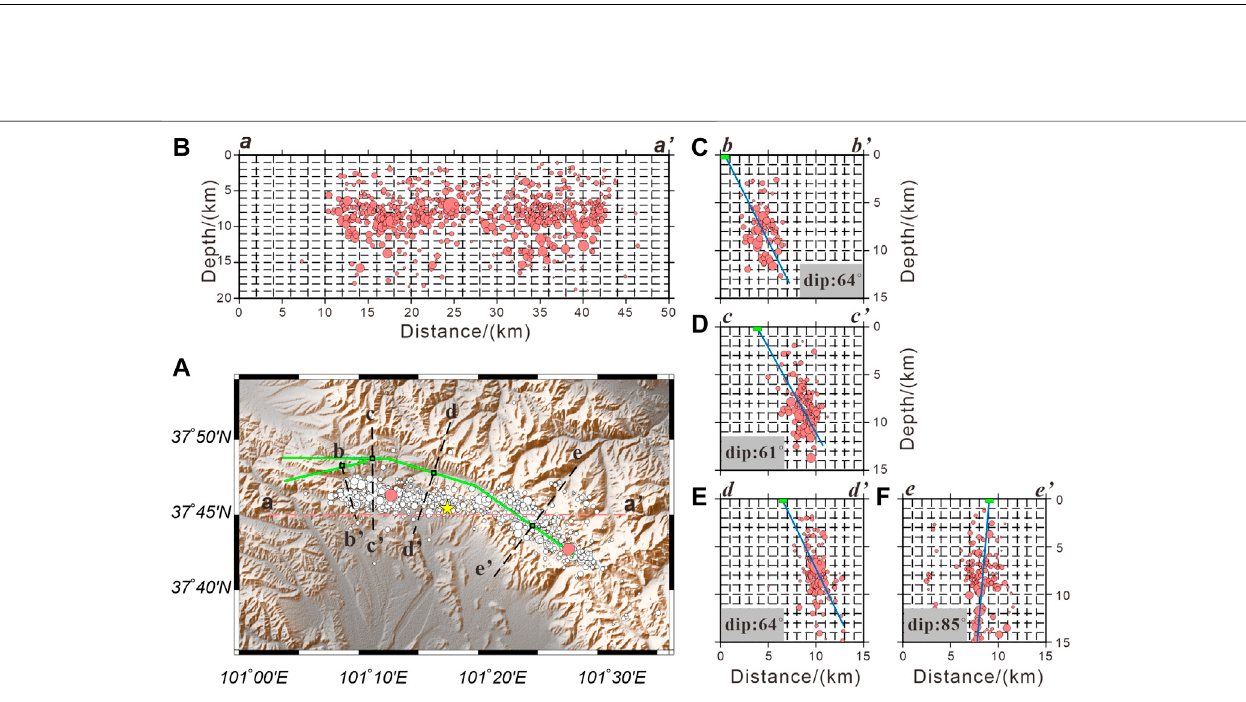
FIGURE 9 | Surface rupture traces and aftershock distribution. (A) The background image is the azimuth offset of the ascending orbit, and the small white circles represent the aftershocks in 9 days after the mainshock (Yang et al., 2022); (B) The background image is the azimuthal offset of the descending orbit, the white small circlesrepresent theaftershocksof2 days aftertheearthquake(Yangetal.,2022).Greenlinesdenotetheseismogenicfaults;theyellow starrepresentstheepicenterof the mainshock; pink circles represent two aftershocks with magnitude ≥ 5.0, which occurred on January 8 and 12 from left to right, respectively.